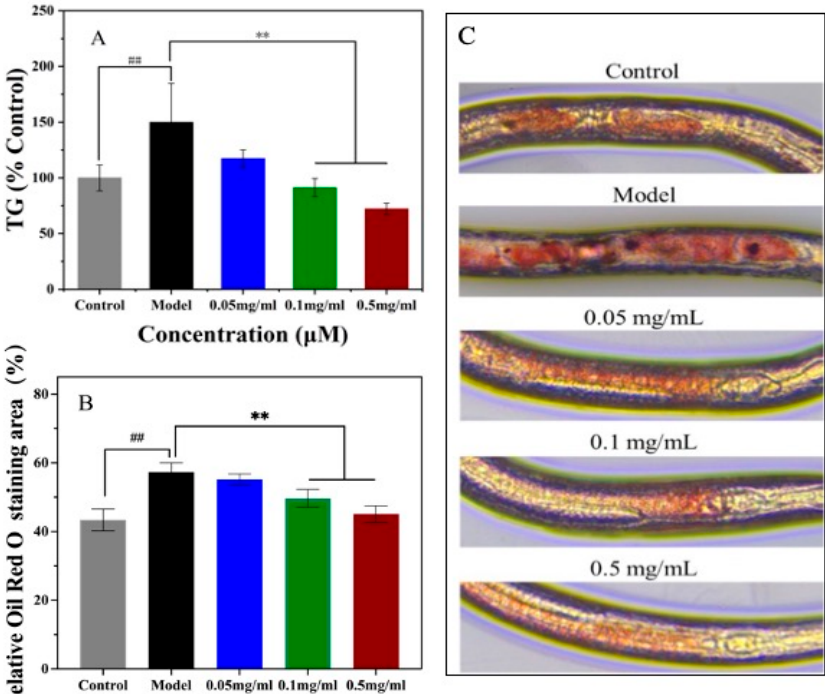
Figure 5. Effect of SPO on triglycerides ( A ), ORO staining of C. elegans ( B ) Effects of SPO on fat accumulation ( C ). All data are expressed as mean ± SD, analyzed with ANOVA with the Dunnett’s comparison test (post-hoc), relative to control ** p < 0.01; relative to model ## p < 0.01.